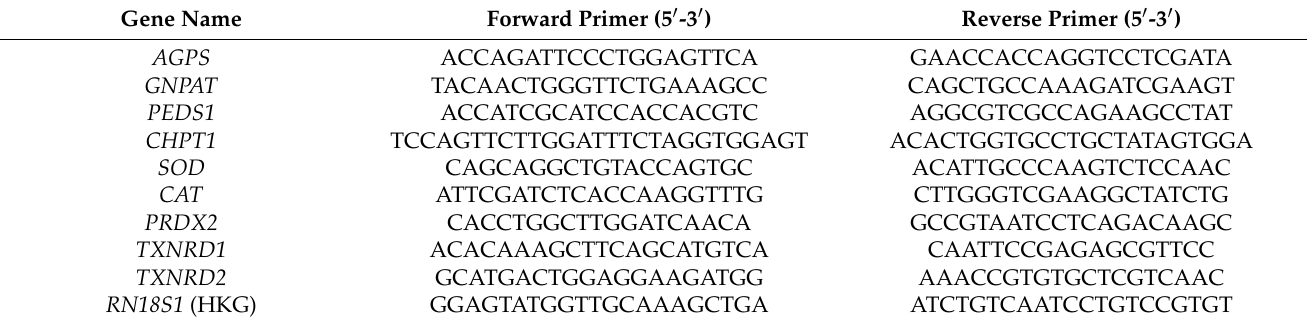
Table 1. Forward and reverse primers used for gene expression analysis of plasmalogen synthe- sis or oxidative-stress-related genes. AGPS: alkylglycerone phosphate synthase; GNPAT: glyc- eronephosphate O-acyltransferase; PEDS1: plasmanylethanolamine desaturase 1; CHPT1: choline phosphotransferase 1; SOD: superoxide dismutase; CAT: catalase; PRDX2: peroxiredoxin 2; TXNRD1: thioredoxin reductase 1; TXNRD2: thioredoxin reductase 2; RN18S1: 18S ribosomal RNA 1; HKG: housekeeping